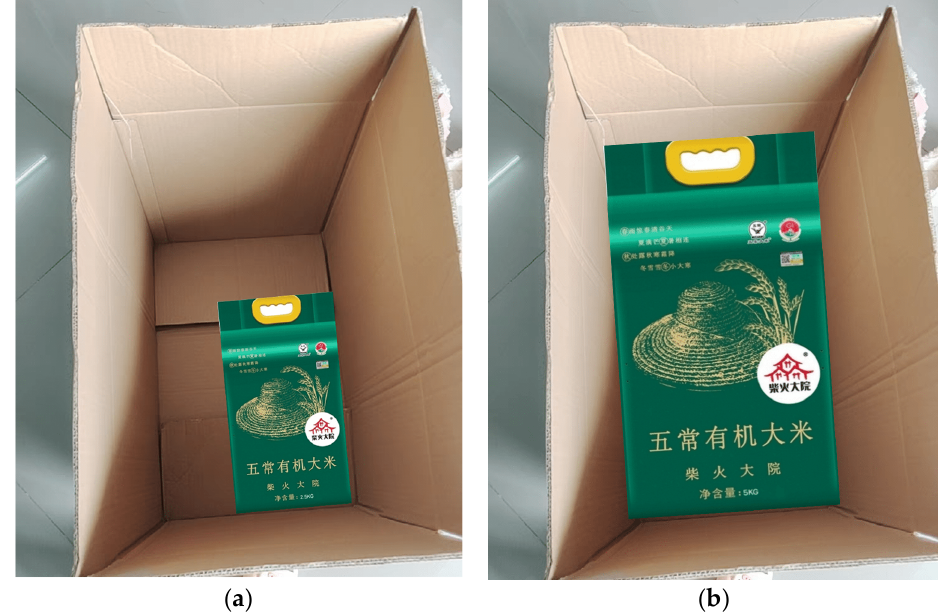
Figure A1. ( a ) Small package size. The Chinese meaning of the above figure is “Small package size ‘firewood yard’ Wuchang organic rice”. ( b ) Large package size. The Chinese meaning of the above figure is “Large package size ‘firewood yard’ Wuchang organic rice”.